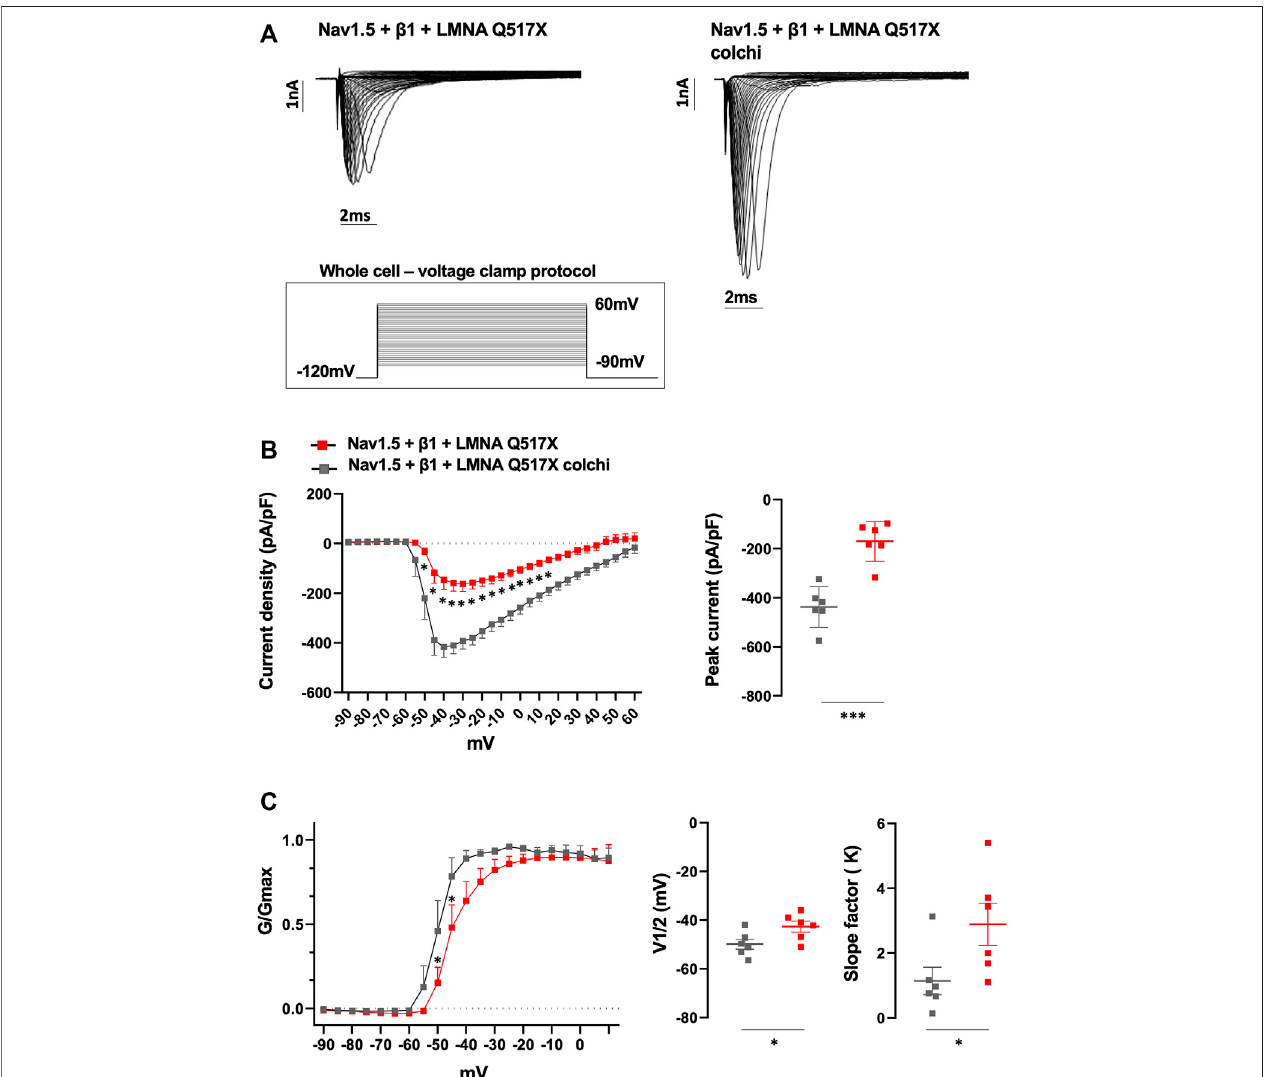
FIGURE 8 | (A) Representative traces of inward Na + currents evoked in untreated (Nav1.5 + β 1 + LMNA Q517X) or colchicine-treated LMNA Q517X-expressing HEK293cells(Nav1.5+ β 1+LMNAQ517Xcolchi). (B) Leftpanel:currentdensity(pA/pF) – voltagerelationships(I – Vcurve)oftheNa + currentsrecordedinuntreated(red trace, N =6),andcolchicine-treatedLMNAQ517X-expressingHEK293cells(graytrace, N =6); p -value < 0,0001from − 50 mVto − 10 mV; p -value < 0.001at − 5 mVand at 0 mV; p -value < 0.01 at5 mVand p -value < 0,05 at 10 mV and 15 mV,two-wayAnova. Right panel: scatter plotofthemaximum peak sodium currents (pA/pF) in untreated (red squares) and in colchicine-treated LMNA Q517X-expressing HEK293 cells (gray squares). (C) Left panel: conductance voltage (G/Gmax) relationships of Na + currents (G – V curve) obtained for untreated (red trace, N = 6), and colchicine-treated LMNA Q517X-expressing HEK293 cells (gray trace, N = 6); p -value < 0.001 at − 50 mVandat − 45 mV,two-wayAnova.Rightpanel:scatterplotofthehalf-maximalconductance(V1 ⁄ 2)andslopefactors(K)inuntreated(redsquares)andin colchicine-treated LMNA Q517X-expressing HEK293 cells (gray squares); * p < 0.01; ** p < 0.001, Student ’ s t test for unpaired data.